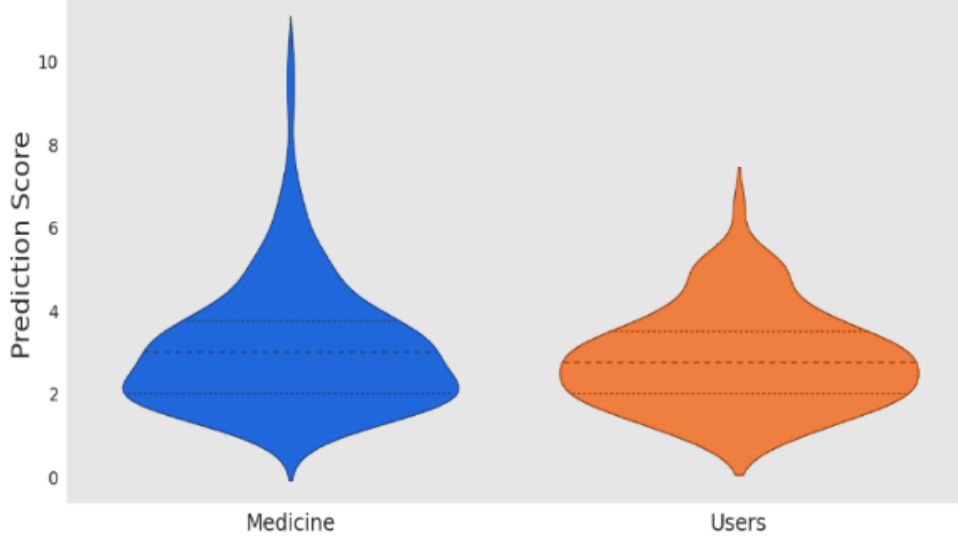
Figure 2. Prediction